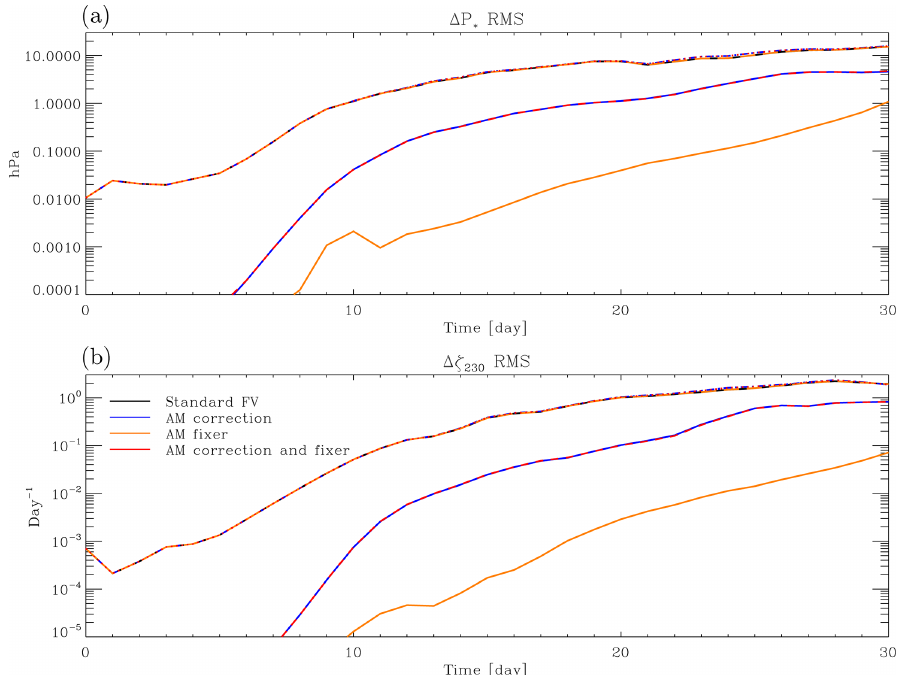
Figure 4. AM correction and fixer in an adiabatic, frictionless baroclinic wave test. The simulations shown in Fig. 3 are compared with a standard CAM–FV simulation at 1 ◦ resolution and against each other. Each panel shows seven curves, four of which nearly overlap and form the topmost set of lines (including the reference simulation with standard FV). These represent the time evolution of the RMS difference of surface pressure (a) and relative vorticity at 230hPa (b) for each of the 2 ◦ integrations and the control 1 ◦ integration. Below that set of curves are two nearly overlapping curves, which show the RMS differences of the 2 ◦ experiments with AM correction only and the control 2 ◦ integration (blue lines), as well as of the experiment with both the AM correction and fixer and the control integration (red lines). Finally, the single yellow lines at the bottom in each panel show the RMS differences of the 2 ◦ integration with the AM fixer only with the 2 ◦ control